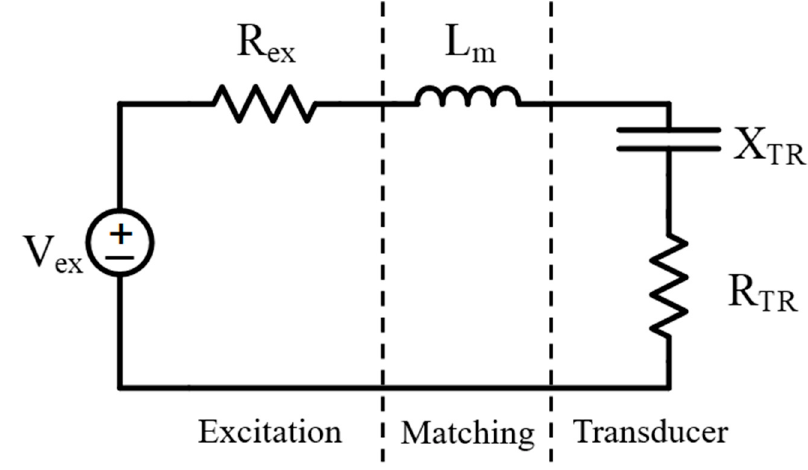
Figure 3. Matched transducer with series inductor and excitation part.